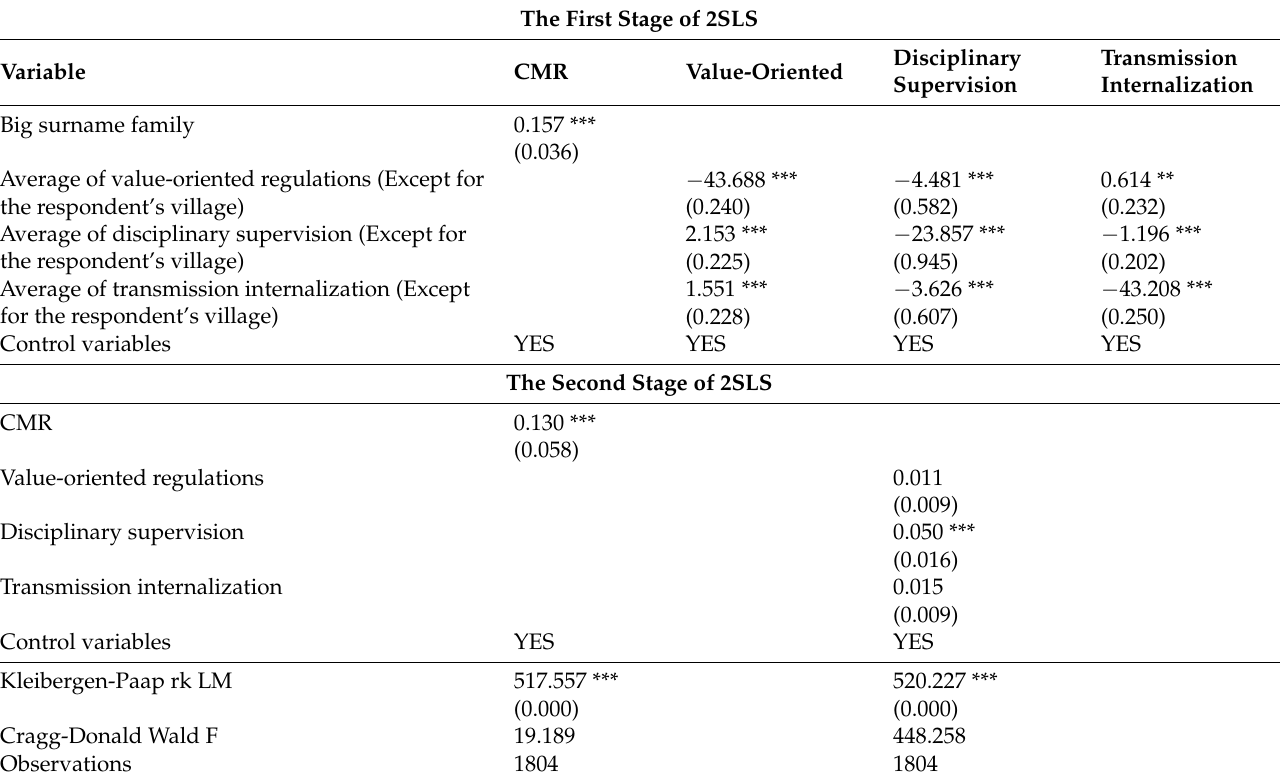
Table 7. The instrumental variable estimation results of CMR and informal